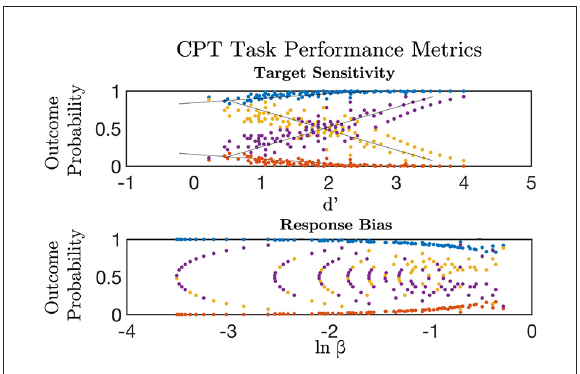
FIGURE1 Signal detection theory metrics were used to estimate discriminative sensitivity (d’) and overall response bias (ln β ) for targets versus lures in the Continuous Performance Task (CPT). d’ increased linearly with higher probability of a Correct Rejection (purple) and response to target (Hits, blue); and declined with greater False Alarm responses (yellow) and Miss rate (red) to targets (top). The probability of a Correct Rejection and response to target was a non-linear decreasing function of increasing response bias (bottom). Greater false alarm rates were indicative of elevated response bias and lower target-lure discrimination.